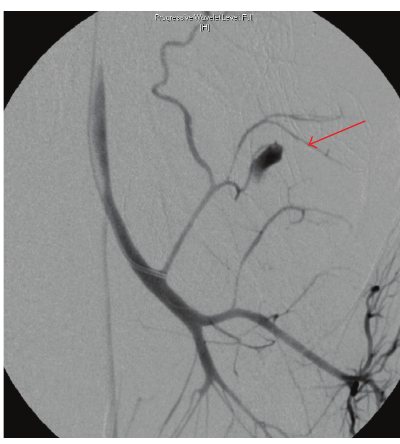
Figure 1: Angiography showing a blush from a dorsal branch from the left internal iliac artery (arrow).